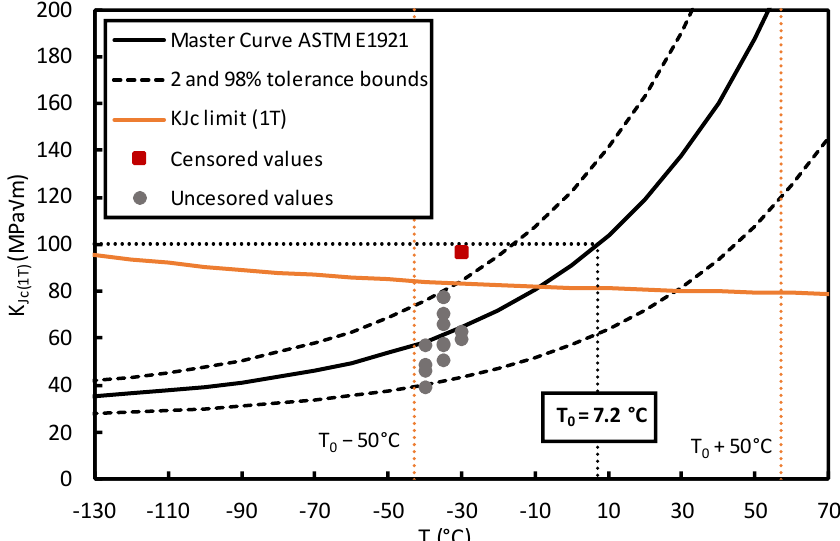
Figure 1. MC for A533B LUS, obtained using mini-CT specimens. Censoring criterion as defined by ASTM E1921 [3].